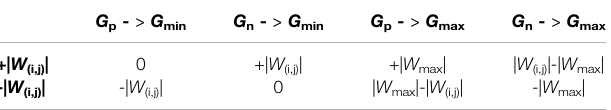
TABLE 1 | All eight results of getting 1 cell stuck at minimum/maximum